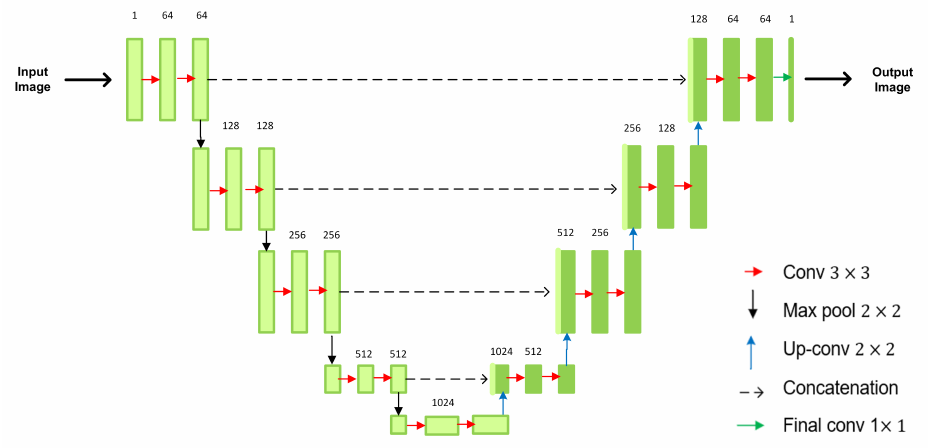
Figure 1. An overview of U-net architecture. The different arrows denote the different operations used in the encoder–decoder